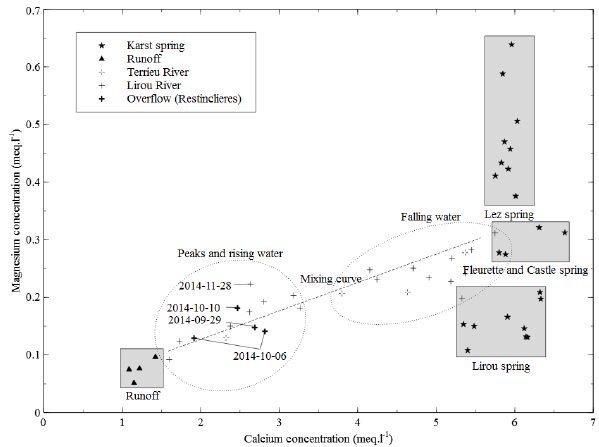
Figure 3. Rating curves, flood events and water trap flow obtained with the hydraulic model.